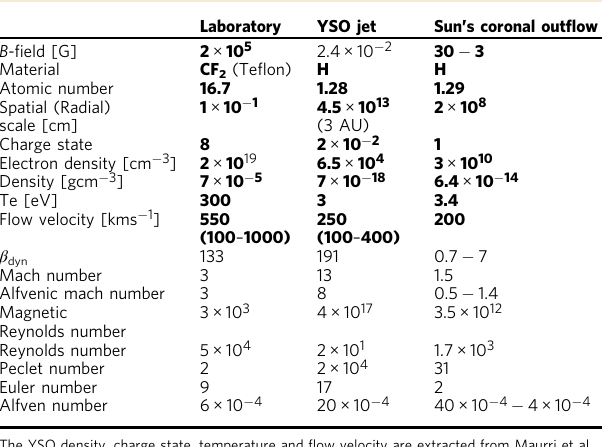
Table 1 Comparison and scalability between the laboratory, a YSO, and a coronal solar out fl ow.